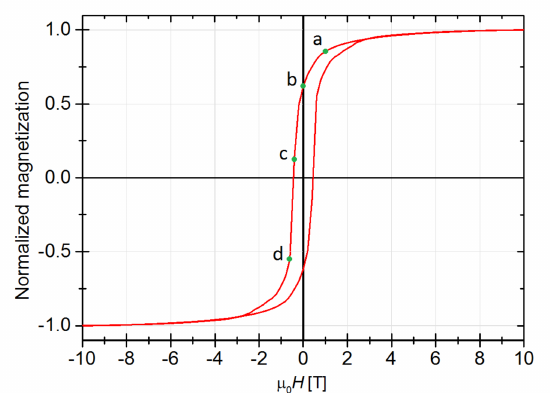
Figure 9. Simulated hysteresis loop for the fractal with the highest | BH | max i.e., S = 0.7, n = 1, K S = 5 × 10 − 4 eV, K V = 0 eV and N S /( N S + N V ) = 0.7. The a–d points correspond to the spin configurations in Figure 10.